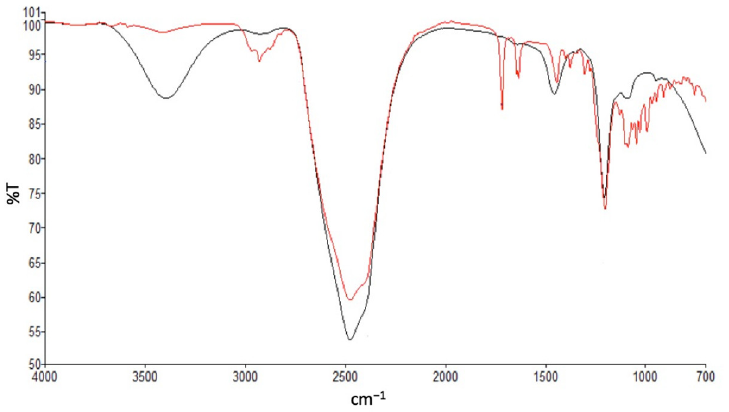
Figure 1. ATR-FTIR spectra of rapamycin-unloaded micelle (red line) and rapamycin-loaded micelle (black line) in deuterated water.